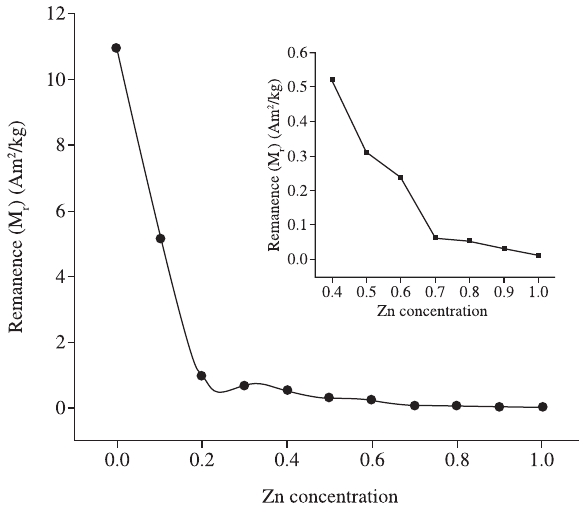
Figure 6. Variation of remanence with Zn concentration for Ni x varying from 0 to 1.0 (Inset: Variation of remanence with Zn concentration for Ni Zn Fe O with x varying from 0.4 to 1.0.). 1-x x 2 4